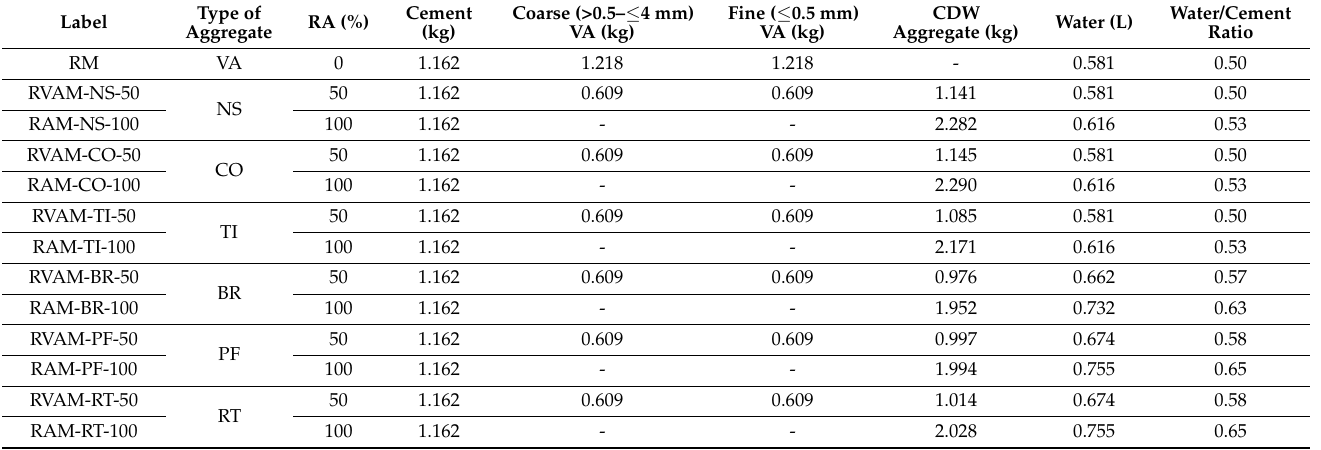
Table 1. Recycled (RA) and virgin (VA) aggregates, cement and water amounts used for the prepara- tion of mortars.